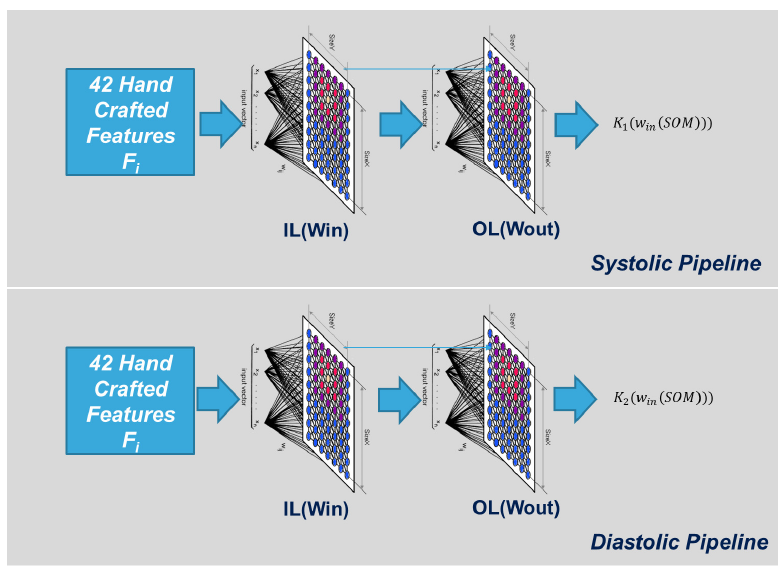
Figure 7. Self-Organizing Map (SOM) motor map proposed pipeline. IL, Input Layer; OL, Output